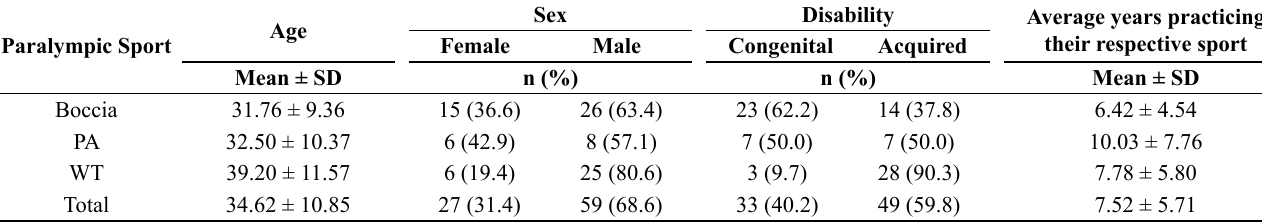
Table 1. Characterization of the research participants.